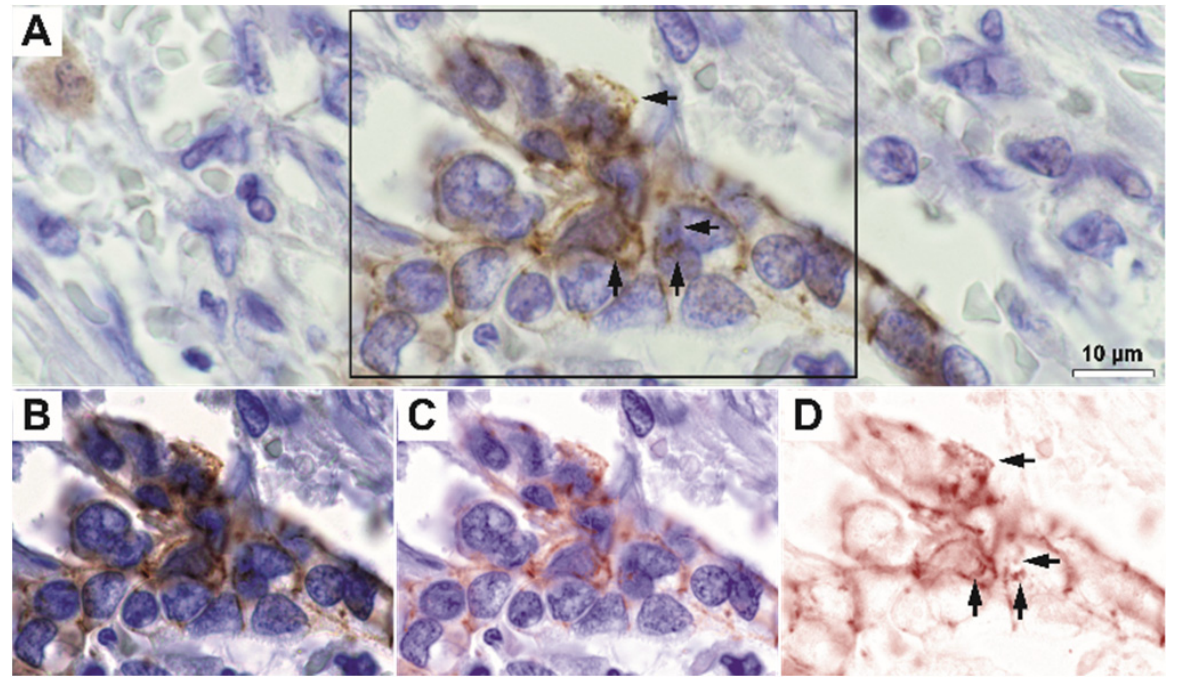
Figure 3. Exemplary image of solid gastric adenocarcinoma stained for E-cadherin. ( A ) RGB image and ( B – D ) unmixed individual and merged images showing membrane and granular and diffuse intracytoplasmic staining (arrows). The rectangle in Figure ( A ) represents the selection illustrated in images ( B – D ). Scale bar for images ( A – D ), 10 µ m.